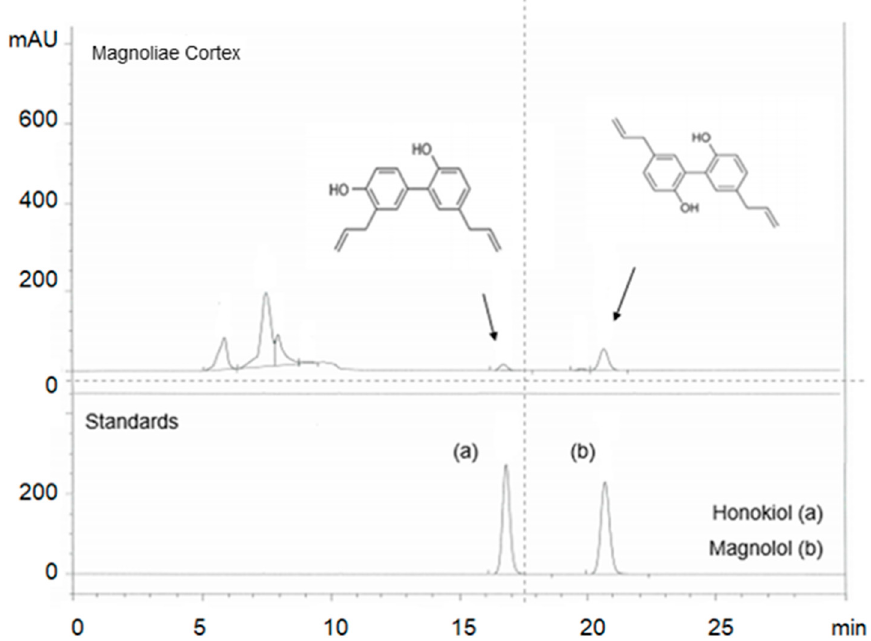
Figure 1. Identification of the active components in Magnoliae by Cortex using HPLC. Two major compounds of Magnoliae Cortex (M.C), honokiol (0.8%) and magnolol (2.1%), were identified using HPLC by comparing the retention time and UV spectra of the standard compounds.